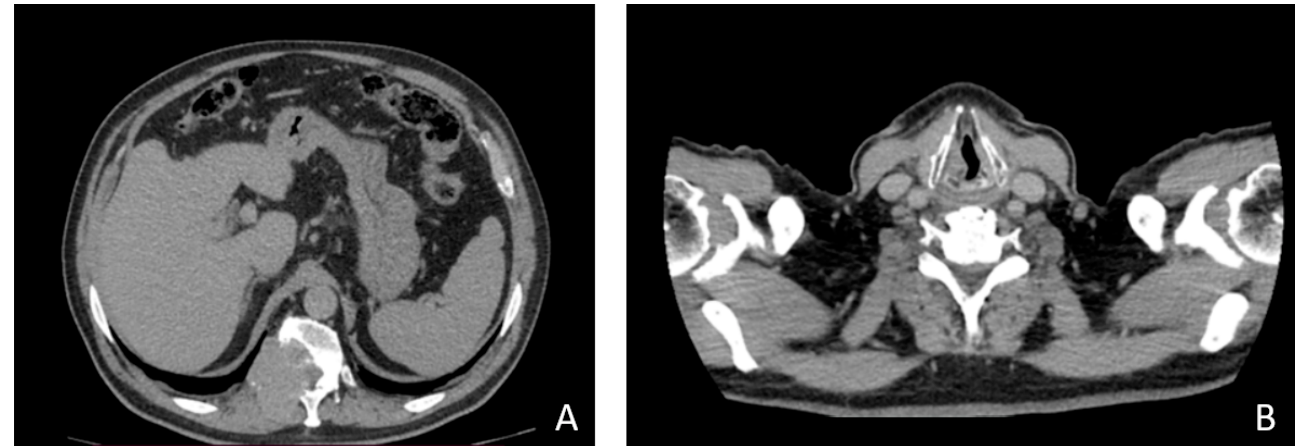
Figure 2. April 2021 CT Scan ( A ) Solid tissue infiltrating the D12 vertebral body; ( B ) neck scan with thyroidectomy outcomes.